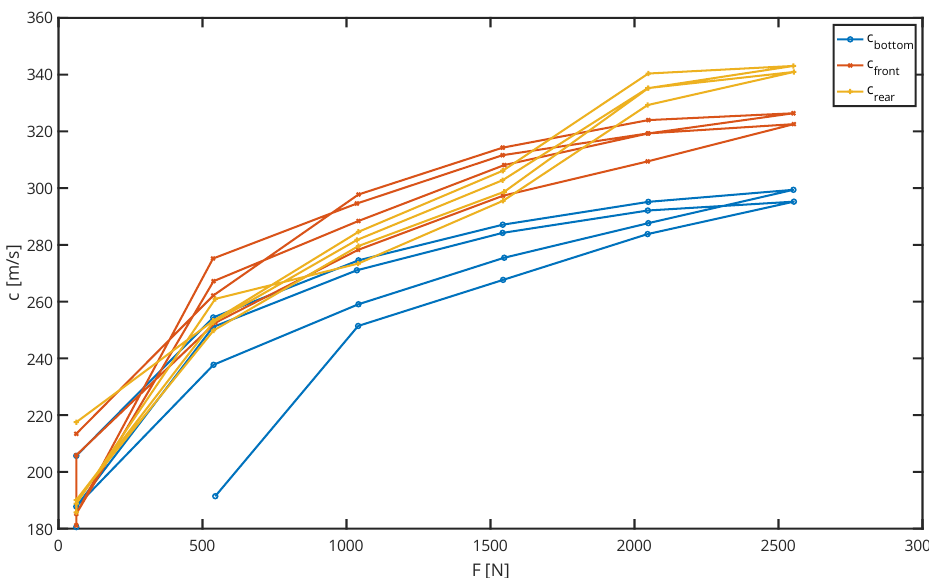
Figure 13. P-wave velocity depending on the test